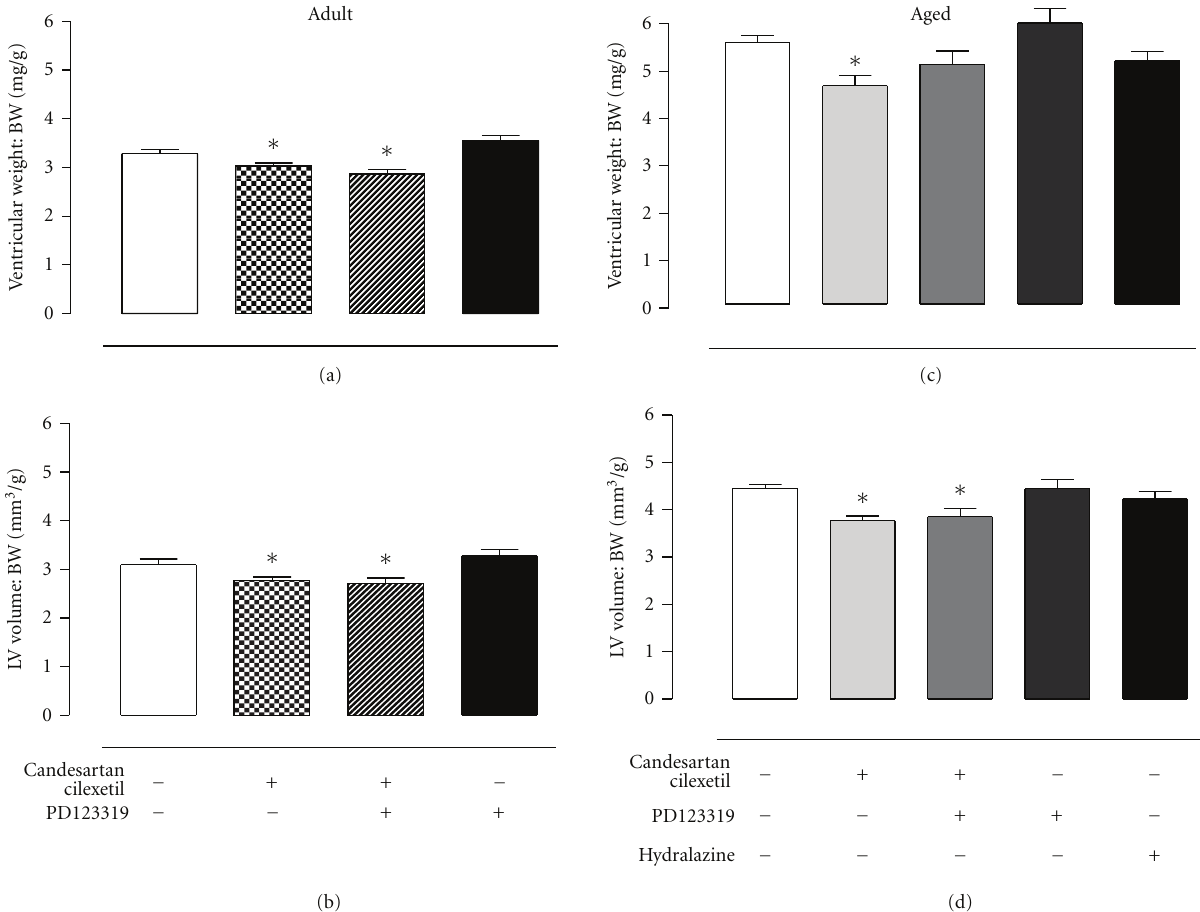
Figure 2: (a) Ventricular weight to body weight (BW) ratio and (b) left ventricular (LV) volume to body weight ratio of adult SHRs, at baseline and during treatment with vehicle (control, n = 4), candesartan cilexetil (2mg/kg/day) alone ( n = 4), or in combination with PD123319 (10mg/kg/day, n = 4), and PD123319 alone ( n = 7). (c) Ventricular weight to BW ratio and (d) LV volume to BW ratio of senescent SHRs, at baseline and during treatment with vehicle (control, n = 10), candesartan cilexetil (2mg/kg/day) alone ( n = 9), or in combination with PD123319 (10mg/kg/day, n = 9), PD123319 alone ( n = 4), or hydralazine (30mg/kg/day, n = 7). ∗ P < 0 . 05 versus control (1-way